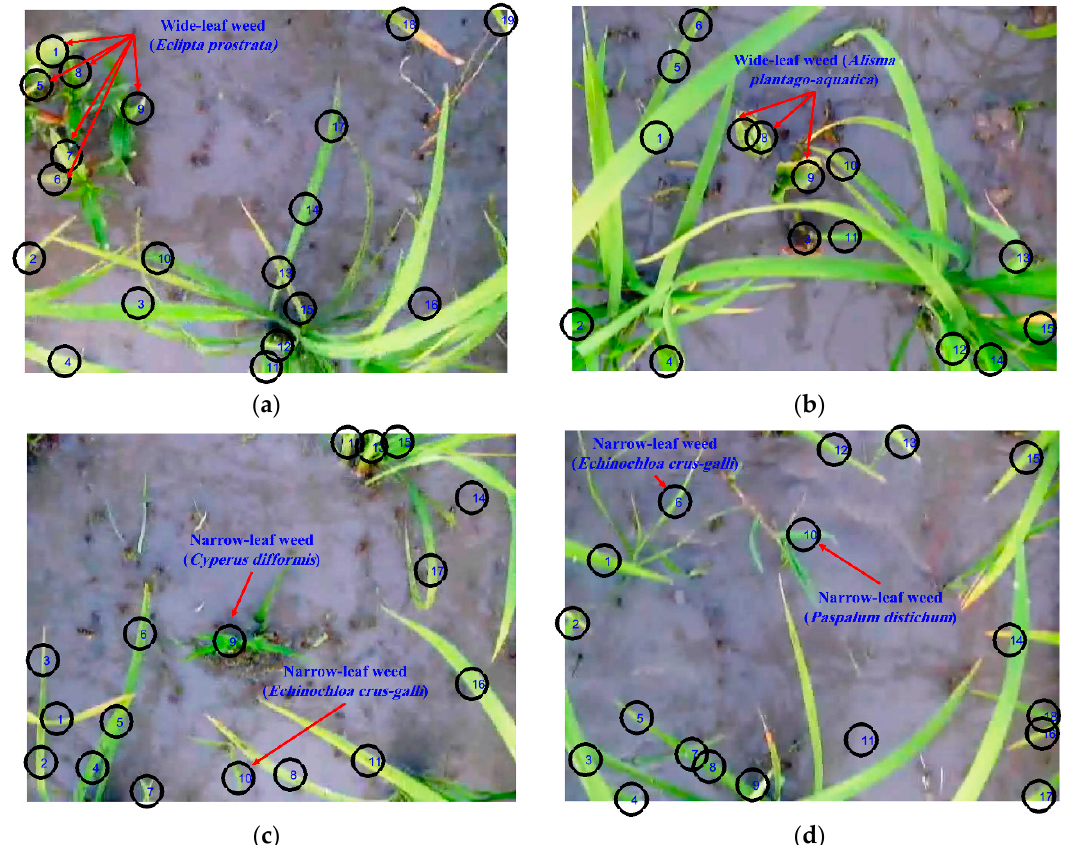
Figure 2. Segmentation of the green components (weeds and rice crop) of sample frames for ( a ) wide-leaf weed ( Eclipta prostrata ), ( b ) wide-leaf weed ( Alisma plantago-aquatica ), ( c ) narrow-leaf weeds ( Cyperus difformis and Echinochloa crus-galli ), and ( d ) narrow-leaf weeds ( Echinochloa crus-galli and Paspalum distichum ).